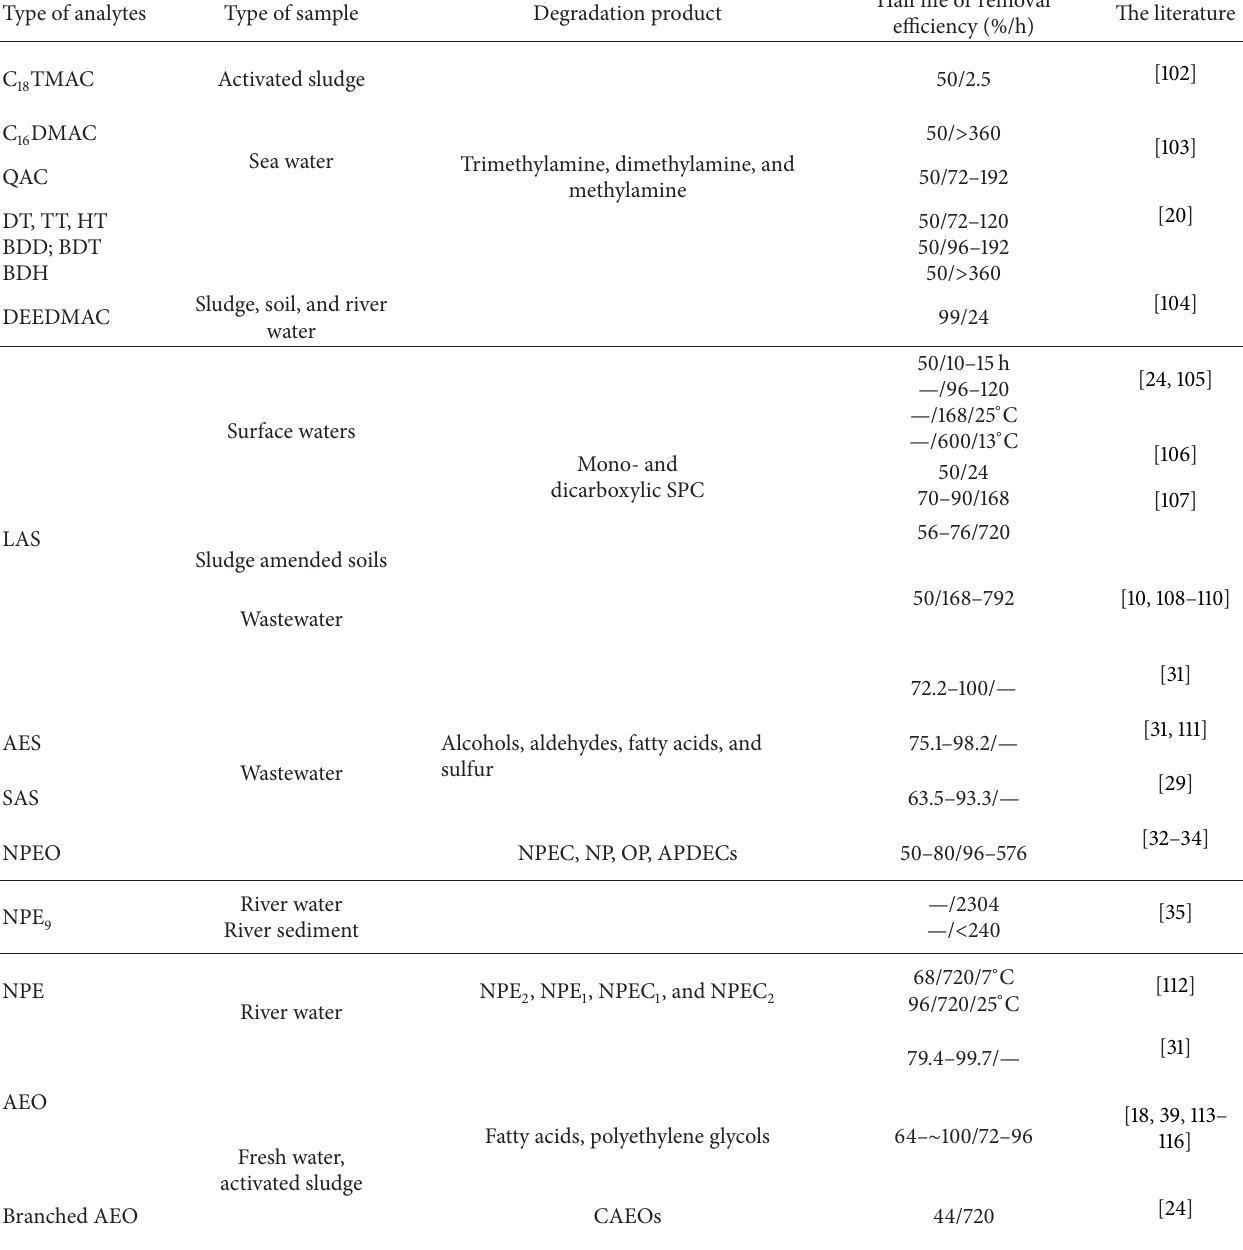
Table 3: Research data of aerobic biodegradation assay of selected